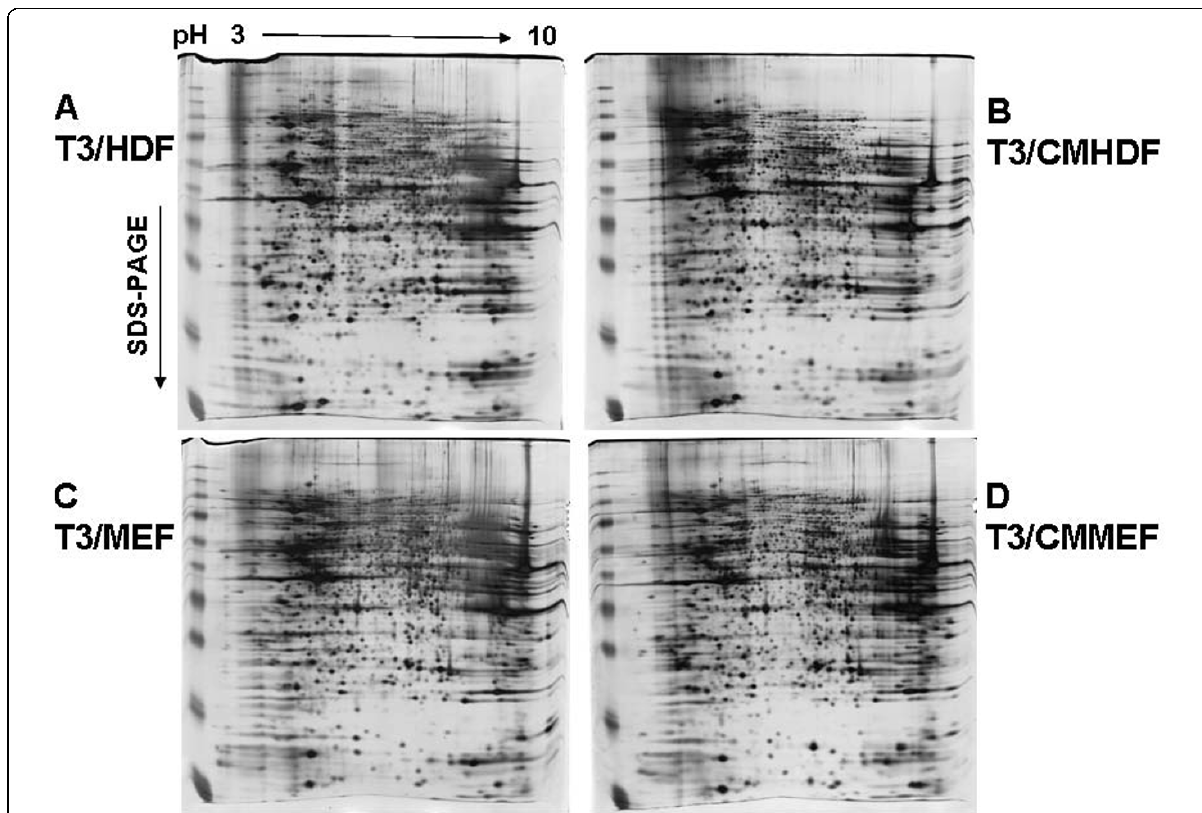
Figure 4 Protein patterns on 2D-gel of T3/HDF, T3/CMHDF, T3/MEF and T3/CMMEF cells .